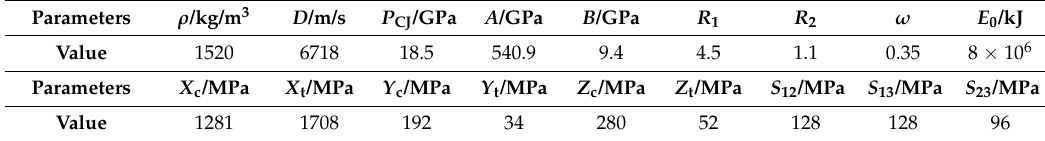
Figure 4. Calculation process of blow-off impulse analysis. Table 7. Main parameters of the high-explosive model, JWL EOS, and 59# constitutive model.